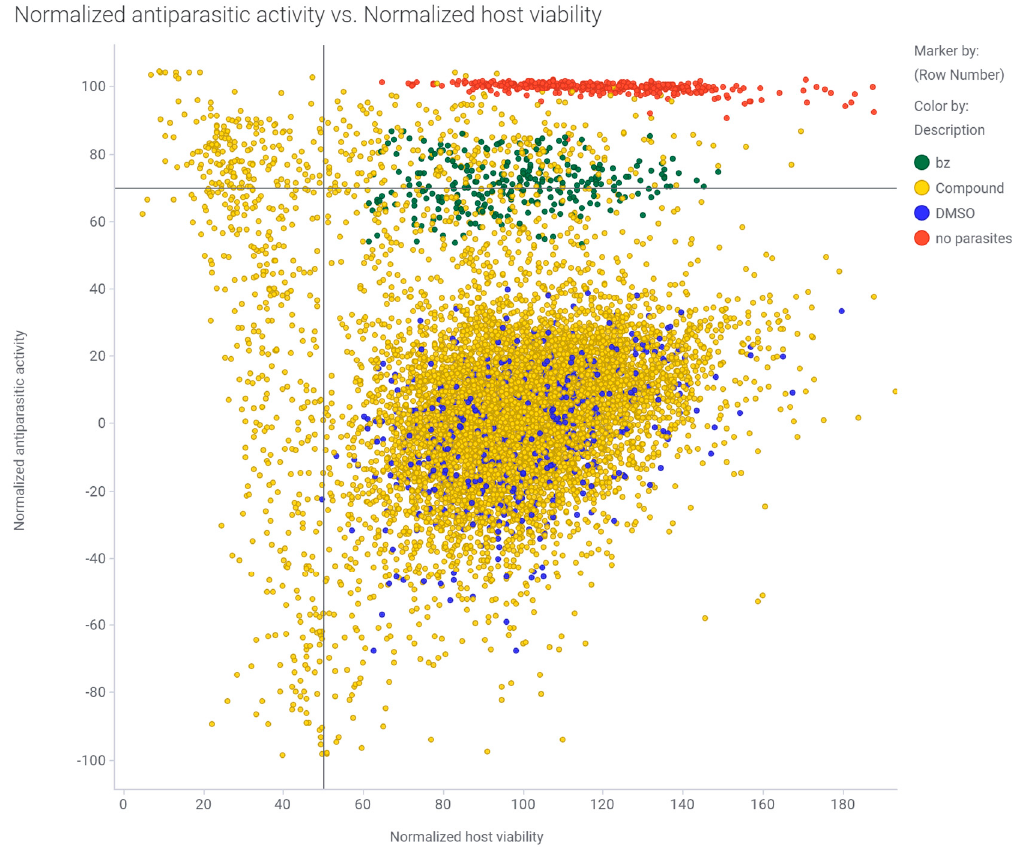
Figure 2. Primary screening data for the Repurposing, Focused Rescue, and Accelerated Medchem (ReFRAME) library against T. cruzi in the phenotypic high-content imaging assay. Scatter plot of normalized % activity against CA-I/72 T. cruzi (normalized antiparasitic activity %, Y-axis) and the host cell C2C12 viability % (normalized host viability %, X-axis) for the ReFRAME library. The red dots represent the uninfected controls, green dots represent 50 µM benznidazole control (reference drug), blue dots represent untreated controls (0.1% DMSO), and the yellow dots are the tested compounds. A vertical line at 50% normalized host viability and a horizontal line at 70% normalized antiparasitic activity highlight the top right quadrant where the compounds were selected as hits for dose-response confirmation.